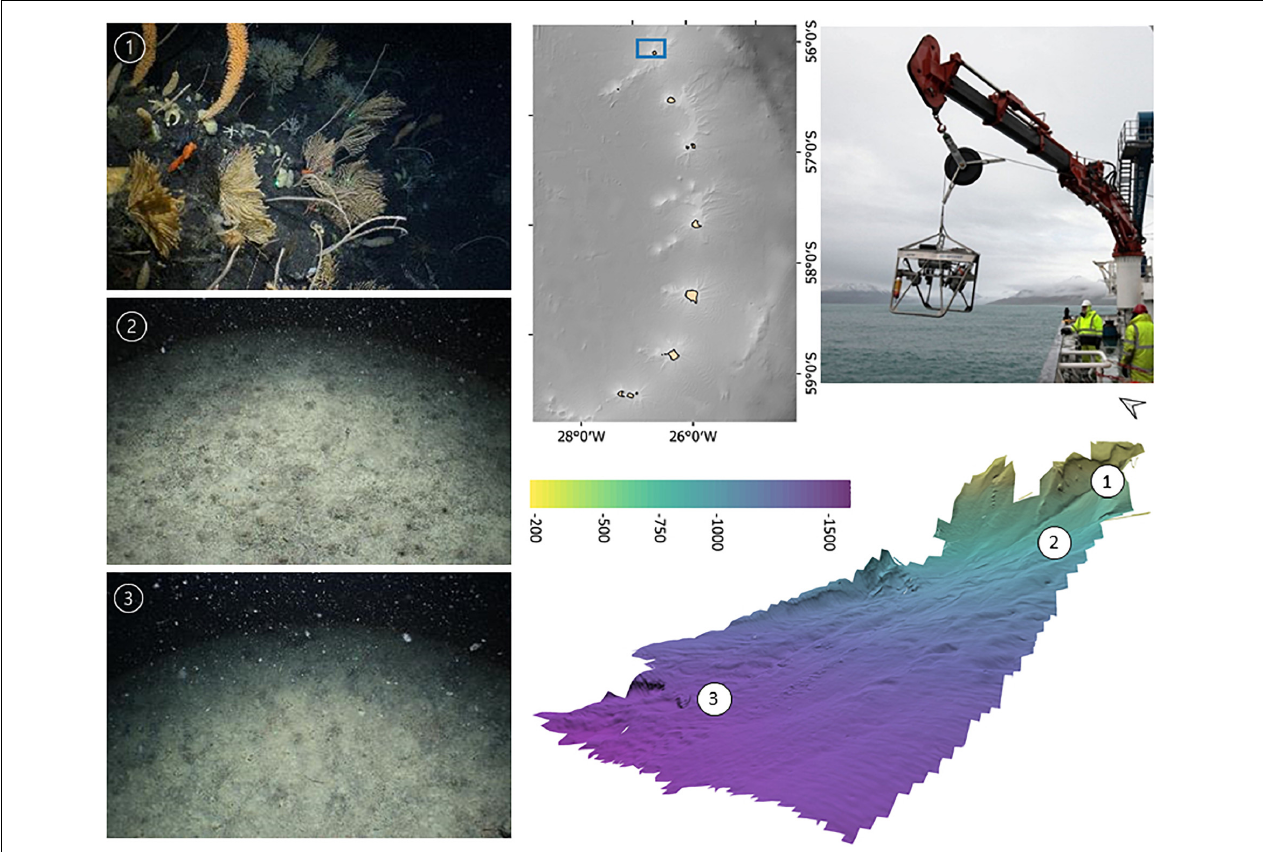
FIGURE 2 | Example of the preliminary bathymetry products used for planning drop-camera transect locations across a representative bathymetric gradient, the camera system used and corresponding habitats observed.